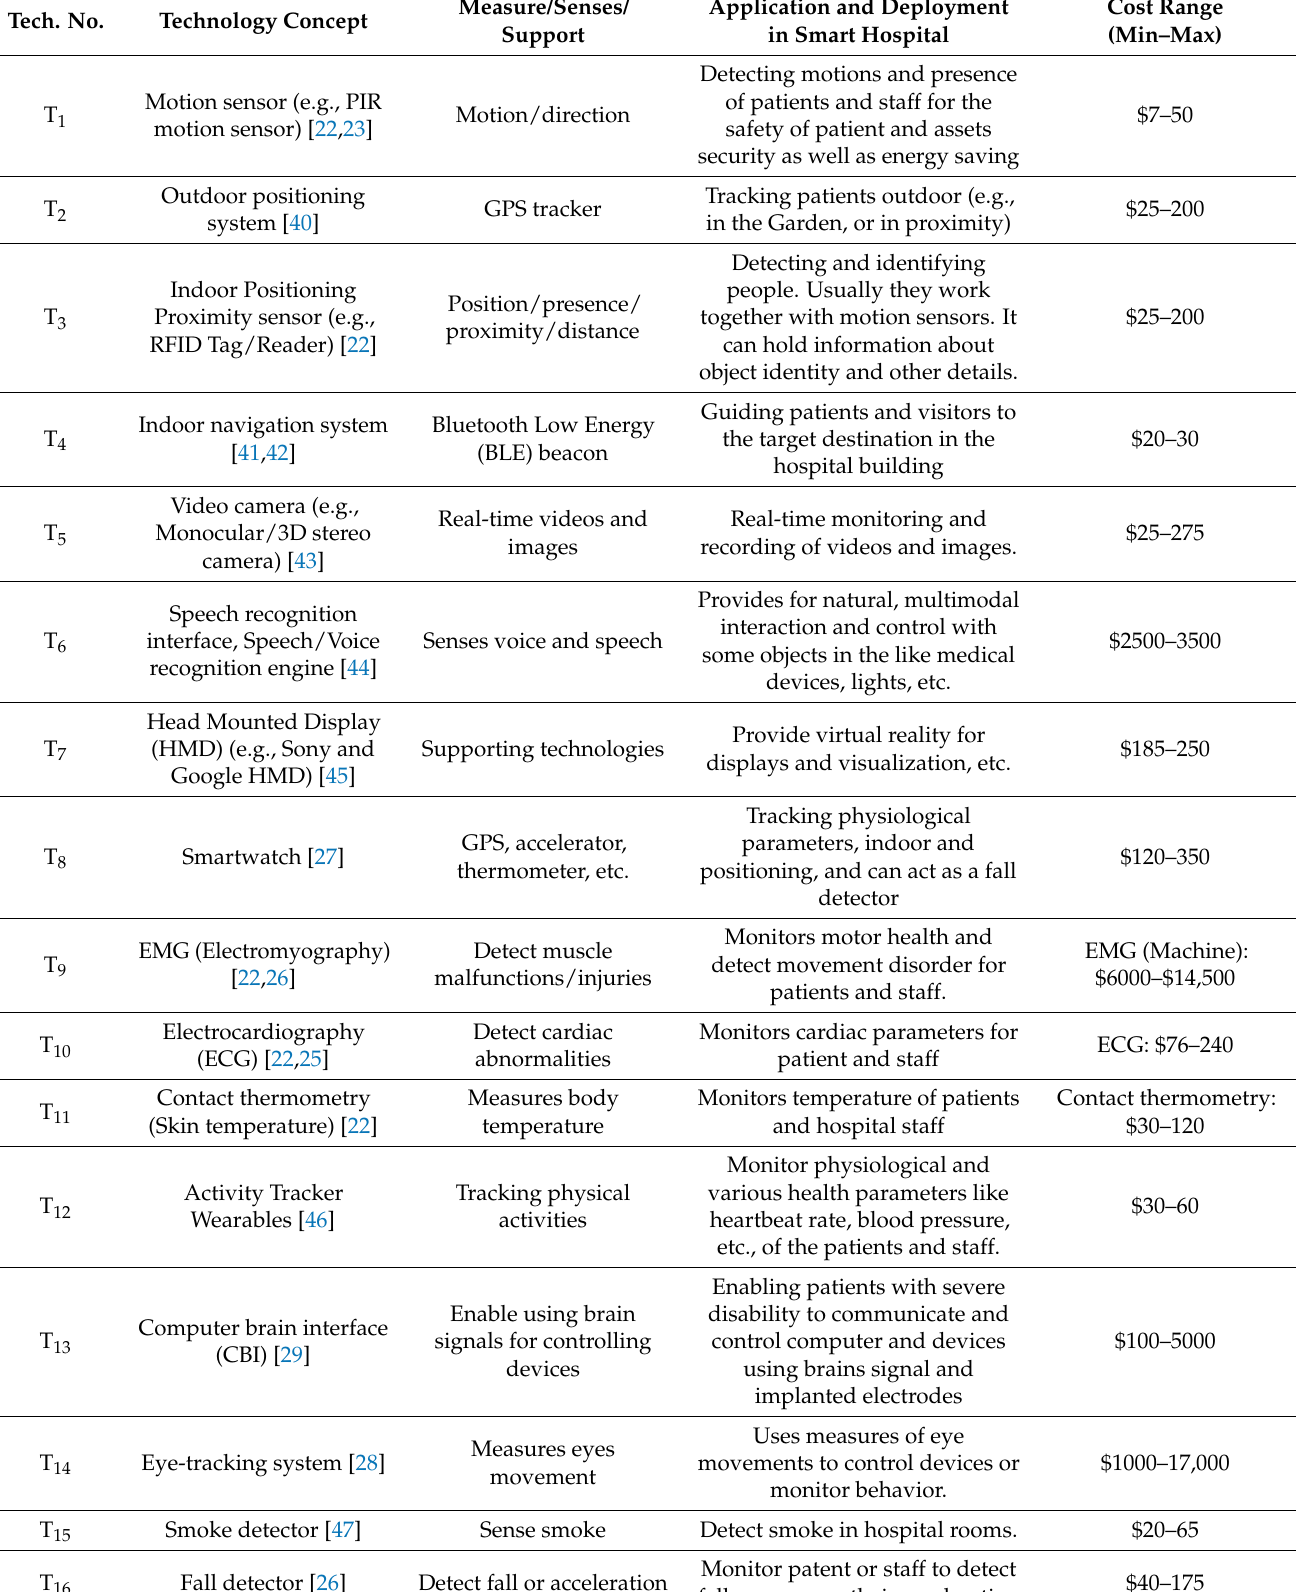
Table A1. List of the smart enabling technologies (SETs), their potential application, estimated cost range. Tech.